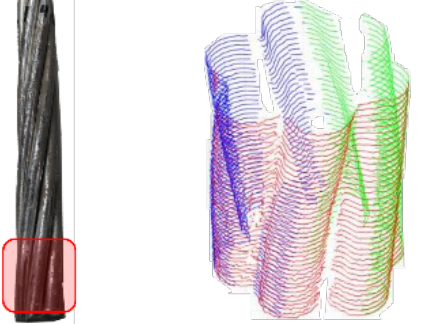
Figure 15: 8 mm diameter aluminium distribution cable – 39 sections with 0.34 mm between